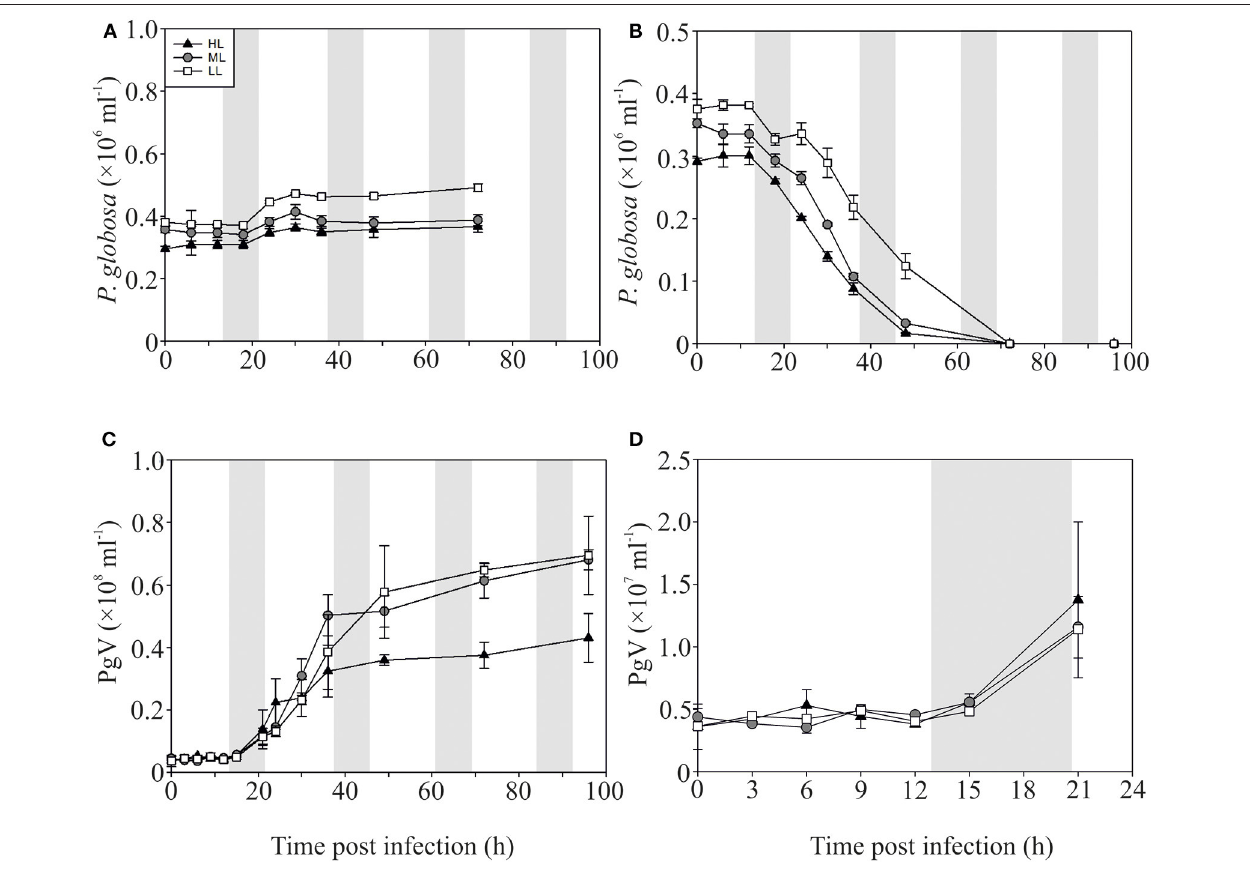
FIGURE 5 | Algal and viral growth curves with abundances of non-infected (A) and infected (B) Phaeocystis globosa and MpV (C) under P-limited conditions. (D) Shows PgV abundances in the first 21h in more detail. Light treatments are depicted by triangles (HL), circles (ML), and squares (LL). Values are averages ± s.d. Gray bar depicts dark (night) period. Note that the scale of Figure 4C is 10-fold lower than Figure 3C